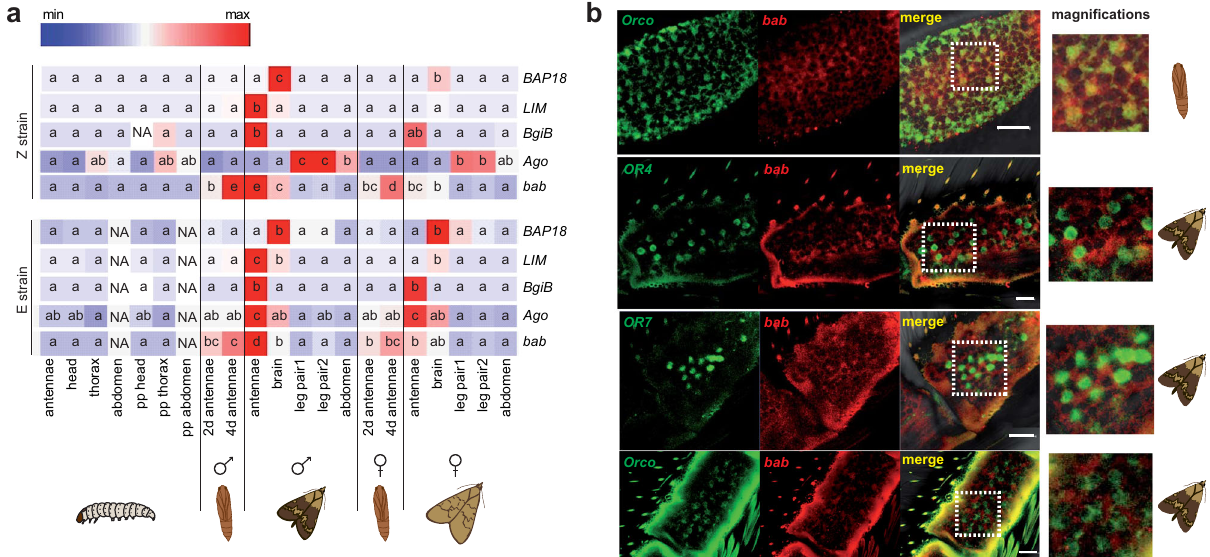
Fig. 1 Tissue-speci fi c and cell-speci fi c gene expression. a Heat map showing tissue-speci fi c, sex-speci fi c, and strain-speci fi c mean expression of Bap18 , LIM , BgiB ago , and bab as determined by RT-qPCR. Red signi fi es higher expression; pp prepupal stage; d days. ANOVAs per candidate gene, and separately for each strain, yielded signi fi cant variation among all tissue by life-stage combinations, after a Benjamini – Hochberg multiple-test correction. Letters indicate signi fi cant differences in two-sided Tukey ’ s HSD post-hoc tests ( P < 0.05). Z strain: Bap18 F = 44.83, df = 20, P = 4 × 10 − 16 ; BgiB F = 3.81, df = 20, P = 9.01 × 10 − 5 ; LIM F = 37.97, df = 20, P = 4 × 10 − 16 ; ago F = 52.11, df = 20, P = 4 × 10 − 16 ; bab F = 155.2, df = 20, P = 4 × 10 − 16 ; E strain: Bap18 F = 7.1, df = 18, P = 2.41 × 10 − 07 ; BgiB F = 7.13, df = 18, P = 1.26 × 10 − 07 ; LIM F = 181.8, df = 18, P = 4 × 10 − 16 ; ago F = 18.31, df = 18, P = 2.61 × 10 − 13 ; bab F = 26.29, df = 18, P = 7.35 × 10 − 16 . b Double whole mount in situ hybridization of differentially labeled transcripts of bab in red (digoxigenin) and odorant receptors and co-receptor in green (biotin). Top images show cells co-expressing both bab and Orco in 4-day-old male pupal antenna. Bottom images show separate but neighboring cells expressing bab and OR7 , OR4 , or Orco (co-localization in the same sensillum) in 2-day-old adult male antenna. In merged images on the right, yellow indicates overlapping of the two signals. Successful demonstrations in pupal antennae were obtained 4 times for bab / Orco combinations. Successful demonstrations in adult antennae were obtained 22 times for bab / OR4 combinations, 8 times for bab / OR7 combinations and 7 times for bab / Orco combinations. The scale bar corresponds to 20 µ m. Source data are provided as a Source Data fi